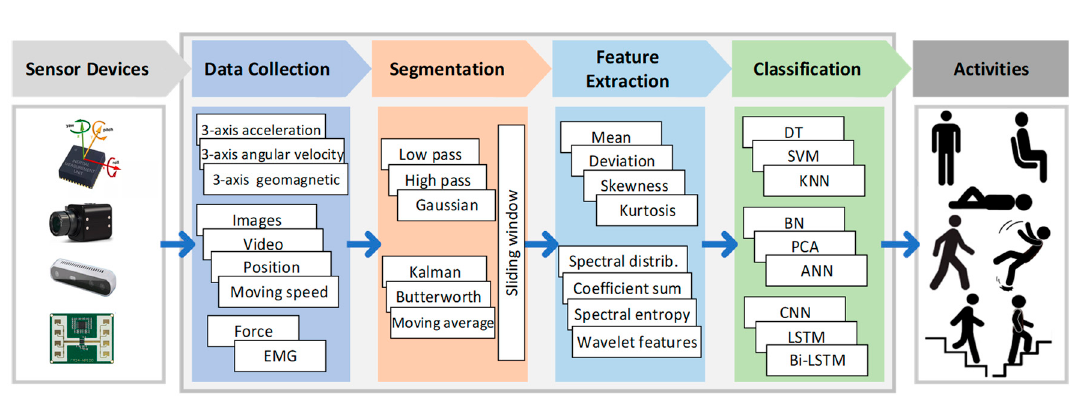
Figure 2. Common methodology for HAR.